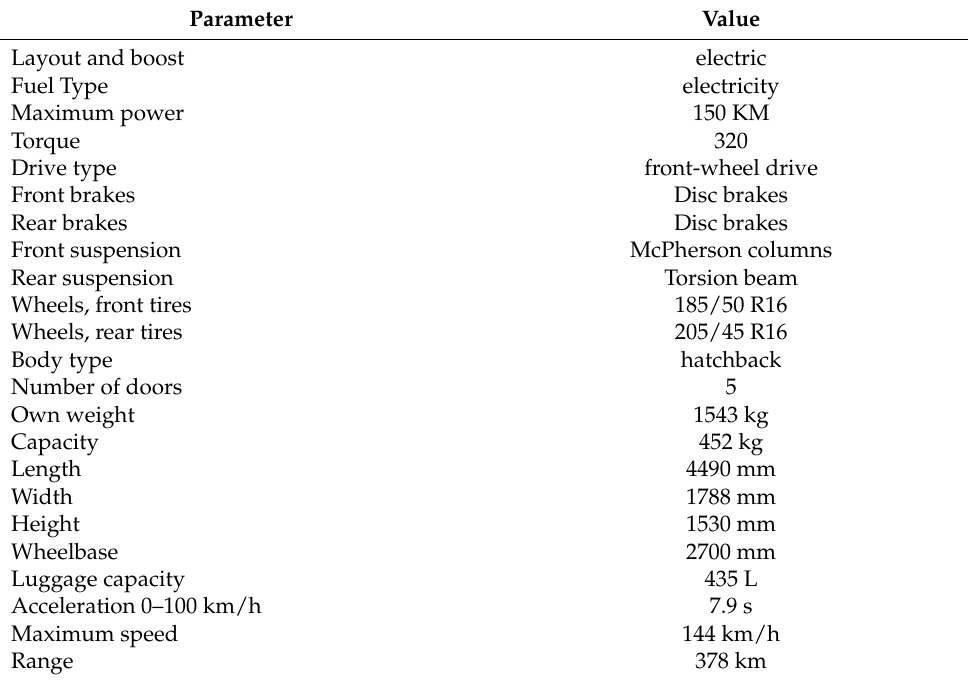
Table 1. The technical data of Nissan Leaf 2018